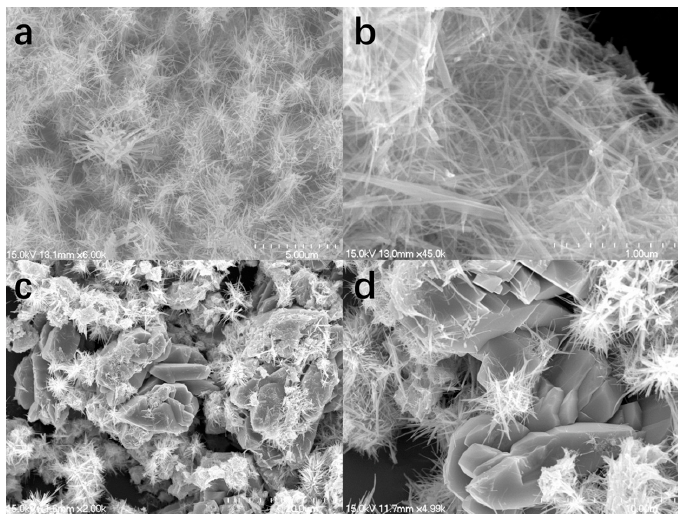
Figure 2. ( a , b ) SEM (scanning electron microscope) images of as ‐ prepared MnPO 4 ∙ H 2 O nanowire/GO composite material; ( c , d ) and as ‐ prepared MnPO 4 ∙ H 2 O sample without GO.